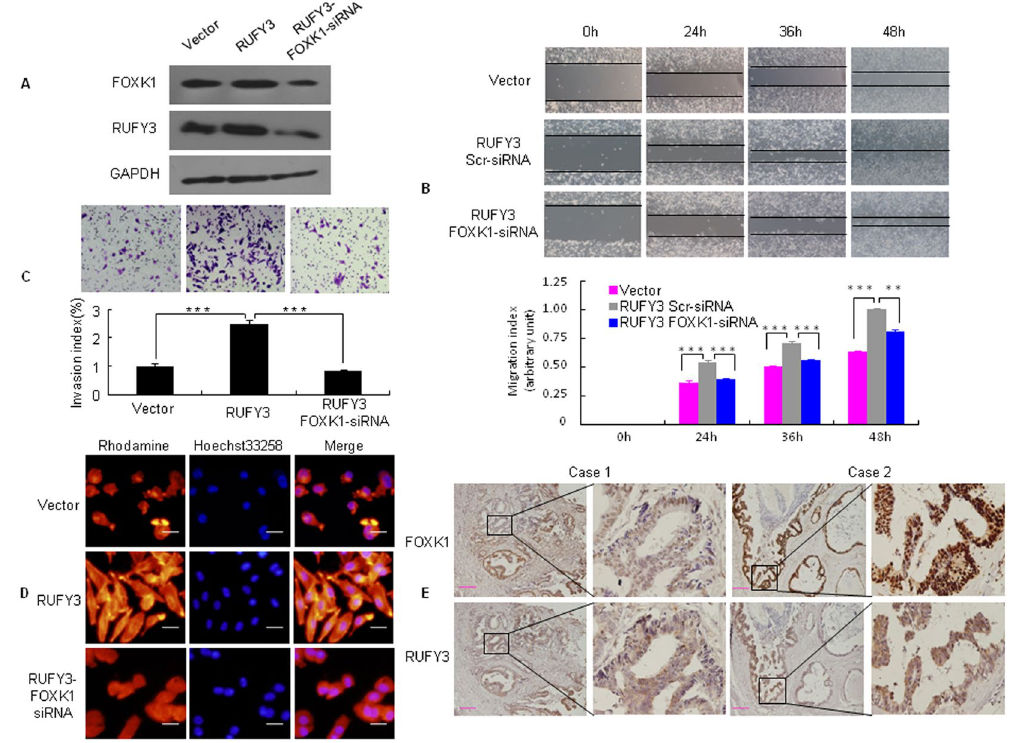
Figure 4. RUFY3 cooperates with FOXK1 to promote the migration and invasion of CRC cells. ( A ) Stable transfectants with vector, pooled stable transfectants with RUFY3 transfected with FOXK1 siRNA, and RUFY3 expression were detected by western blot. ( B ) For the wound healing experiments, cells were analyzed with live-cell microscopy. Original magnification, 10x. *** P < 0.001. ( C ) Invasive potential of LoVo/Vector, LoVo/ RUFY3, and LoVo/RUFY3-FOXK1 siRNA. *** P < 0.001. ( D ) LoVo cells stained with rhodamine-phallotoxin for 48 h to identify F-actin filaments were visualized under fluorescent microscopy. ( E ) Representative IHC images are shown for RUFY3 and FOXK1 expression in lymph node metastatic cancer tissues. Scale bars represent 20 μ m in D and 100 μ m in E . All experiments were repeated three times with similar findings. The full-length blots/gels are presented in Supplementary Figure